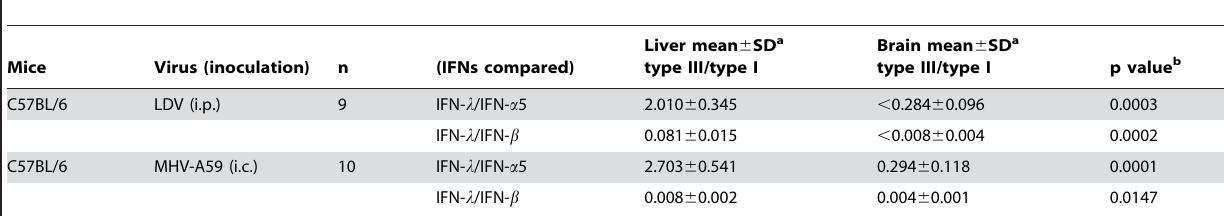
Table 3. Relative type III and type I IFN gene transcription in the brain and in the liver of infected C57BL/6 mice.